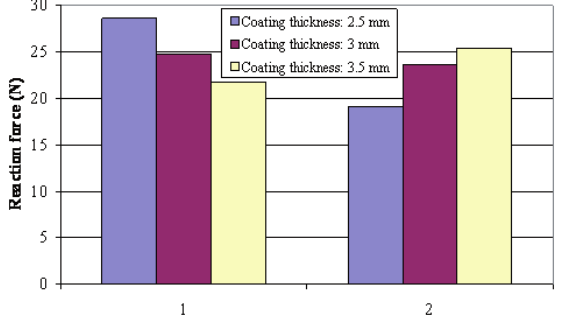
Fig. 15. Reaction force applied to the coating bottom within the range: (1) x ∈ [0 , 1 . 6] – (2) x ∈ [1 . 6 , 2 .